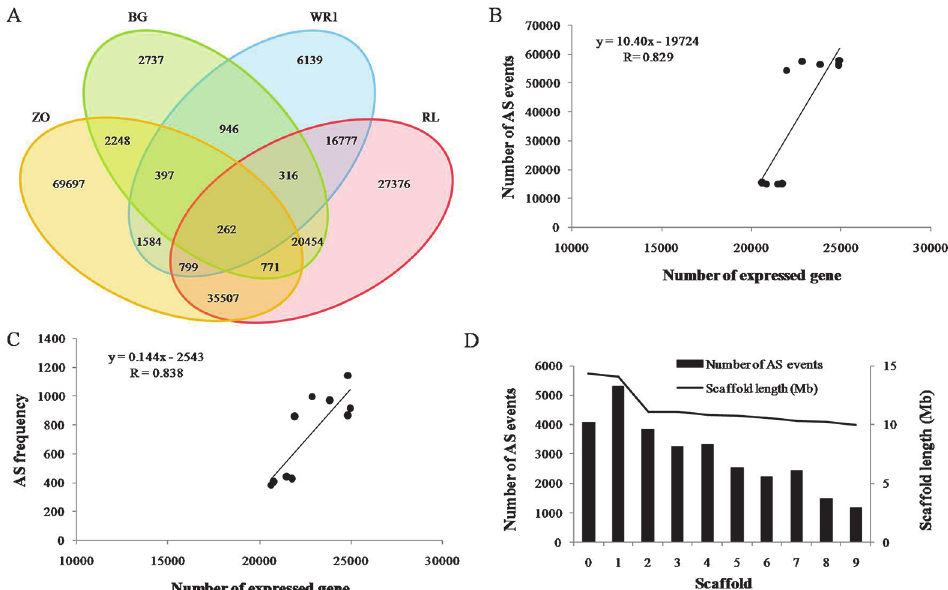
Fig 5. Numbers of AS events and distribution in the lotus Genome. (A) Venn diagram of AS events discovered from the four datasets. (B) Correlations of AS event number with expressed gene number. (C) Correlations of AS frequency with expressed gene number. (D) Distribution of AS events in the lotus genome.